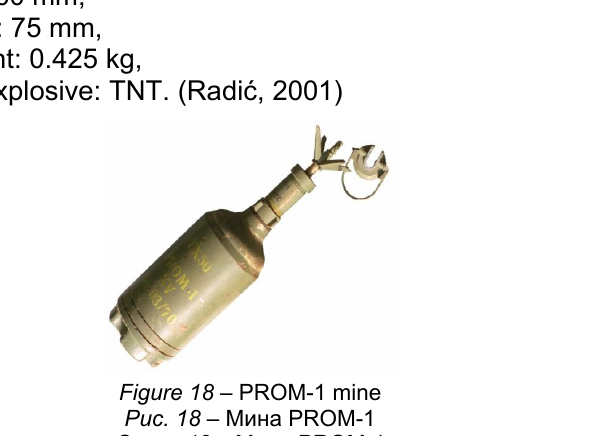
Figure 18 – PROM-1 mine Рис . 18 – Мина PROM-1 Слика 18 – Мина